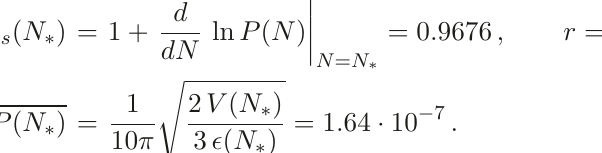
Figure 11 . Evolution of all KK masses (with M (4) and the gravitino mass m